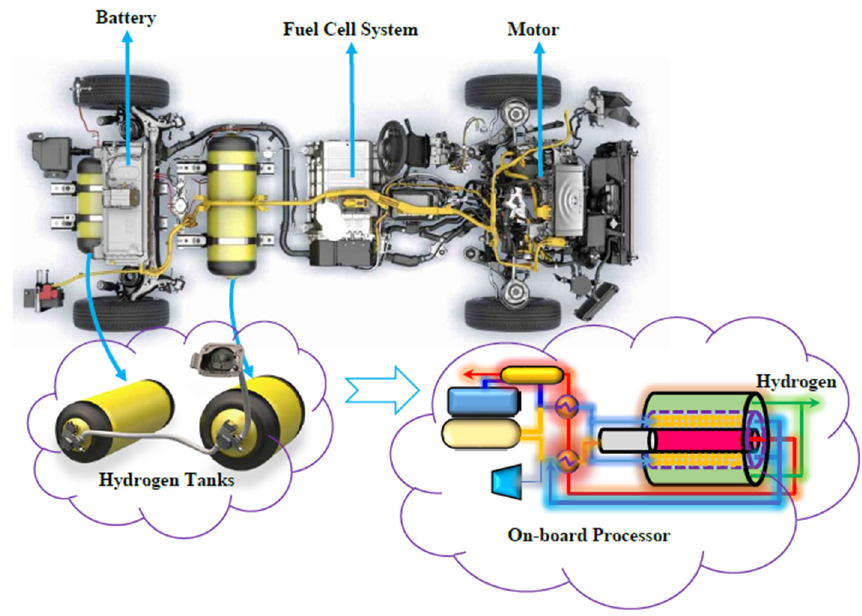
Figure 6. The replacement of the on-board MR combined to a H 2 storage tank on a FCV [36].